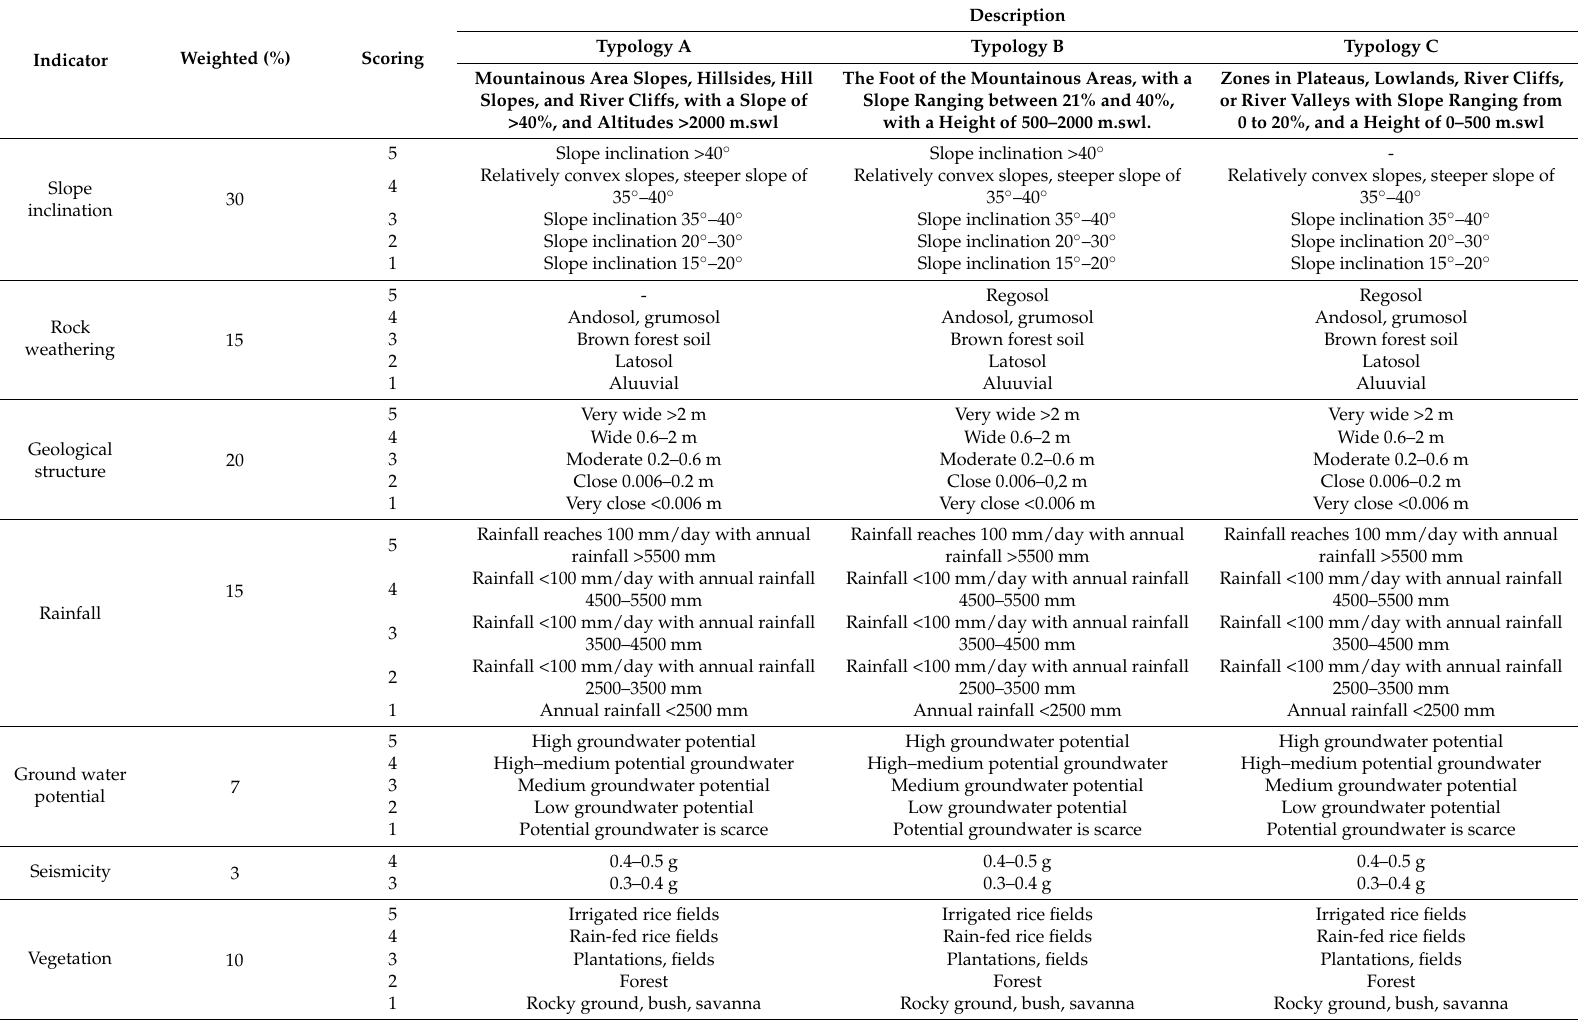
Table 4. The sensitivity level of landslides hazards in each zone based on Regulation No. 22/PRT/M/2007. Mean sea water level